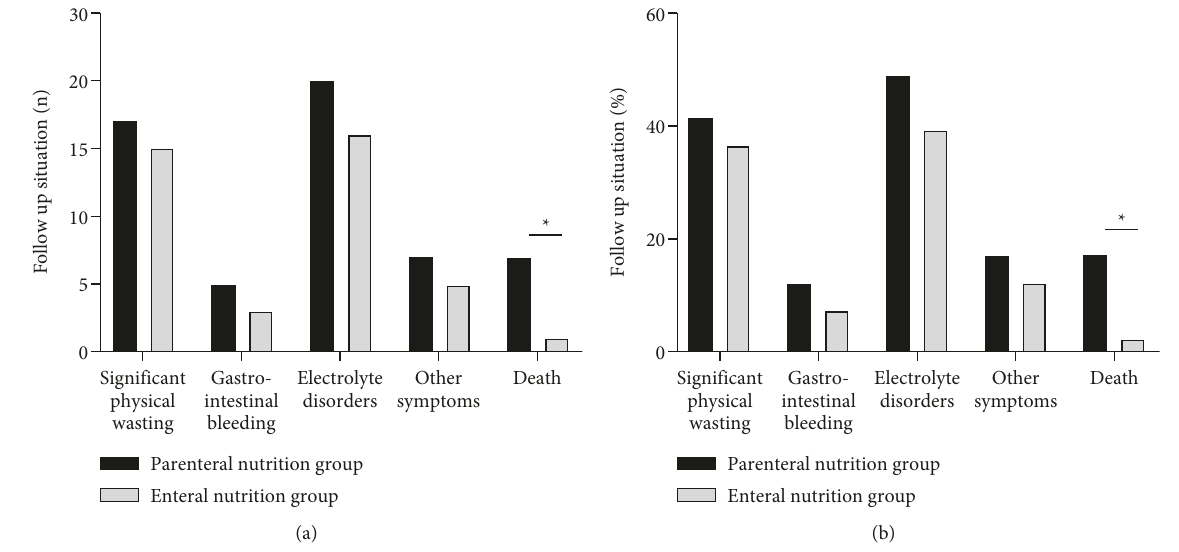
Figure 7: Comparison of follow-up situations between two groups. (a) Case of follow-up situation. (b) Percentage of follow-up situation. There was a statistical difference between two ∗